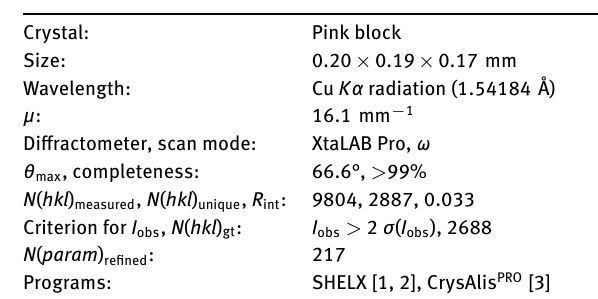
Table 1: Data collection and handling.